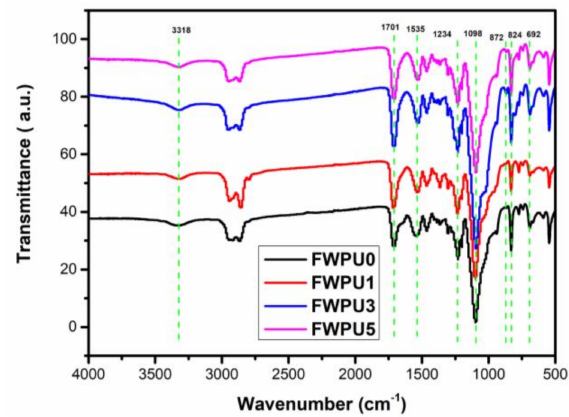
Figure 2. FT − IR spectra of FWPU with different POSS